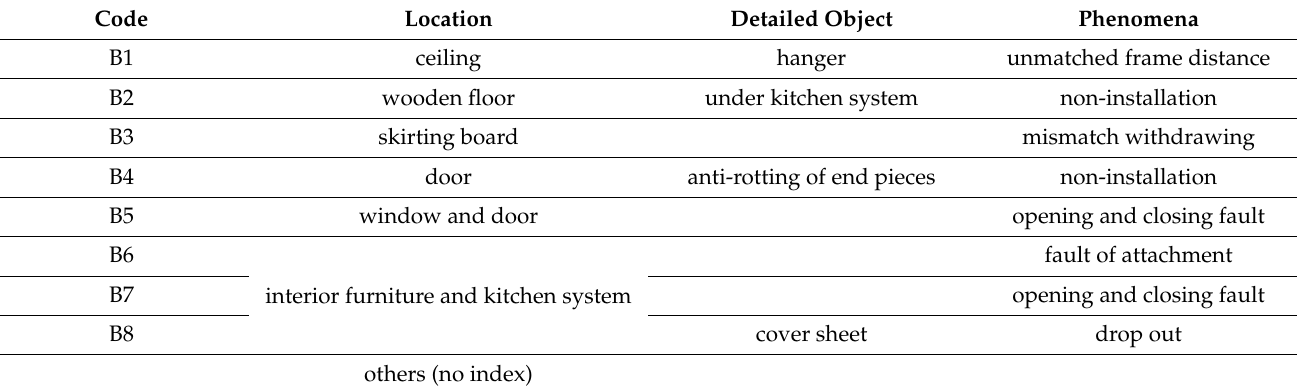
Table 3. Defect index